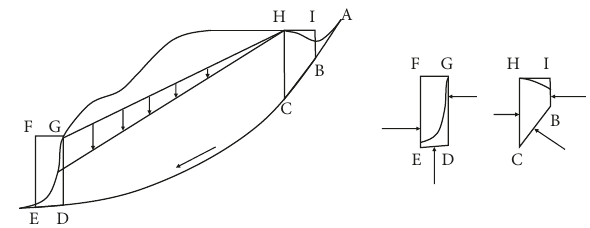
Figure 11: Forces on slopes with arbitrary shapes.